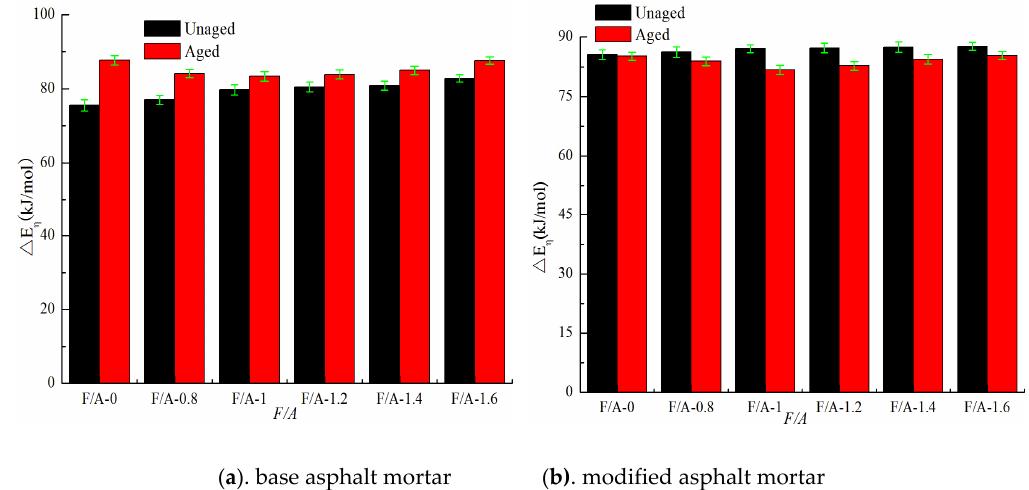
Materials 2020 , 13 , x FOR PEER REVIEW Figure 8. VAI value of modified asphalt mortar. Figure 8. VAI value of modified asphalt mortar.